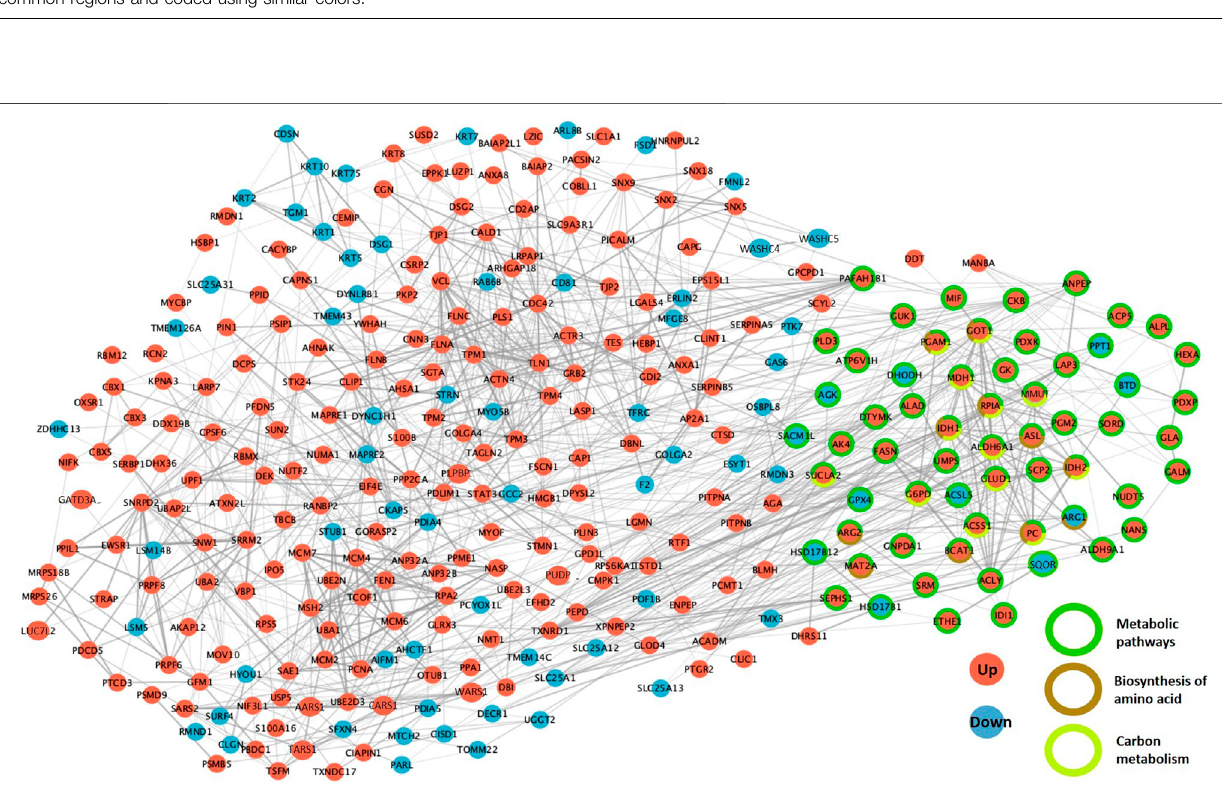
Frontiers in Cell and Developmental Biology |